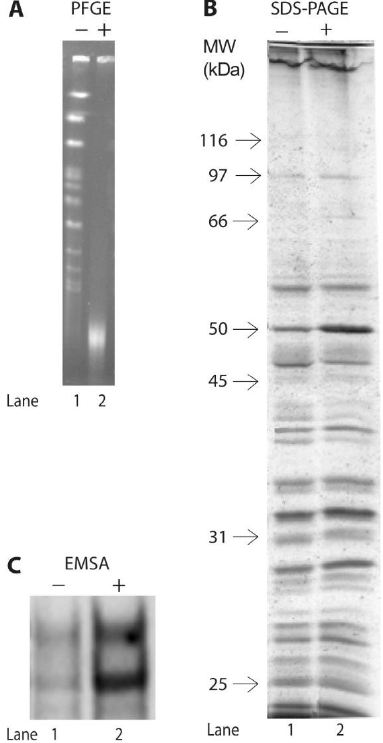
Figure 5. DNA damage, the integrity of proteins, and stability of the Scp53BSF-DNA complexes. Cells in the early stationary phase of growth were incubated with or without bleomycin for 24 h. A : pulsed-field gel electrophoresis (PFGE) illustrating integrity of chromosomes in cells incubated without bleomycin ( − ) and chromosomal destruction in cells incubated with 5 µ g / mL bleomycin ( + ). Equivalent numbers of cells were loaded in each lane. B : The integrity of the proteins extracted from untreated and treated cells. Sixty µ g of protein from nuclear preparations used for Figure 5A were loaded and run on a 10% SDS-PAGE gel. Molecular weights of nuclear proteins were determined by molecular weight standards run in adjacent lanes. Protein integrity was observed in all extracts from untreated and treated cells. C : Comparative EMSAs of 0.45 pmole of radiolabeled SCS, 40-fold excess unlabeled SCS oligonucleotide, and equivalent quantities of protein extracted from untreated cells (-) and 5 µ g / mL bleomycin-treated cells ( + ). Only the two bands corresponding to the Scp53BSF-SCS complexes are